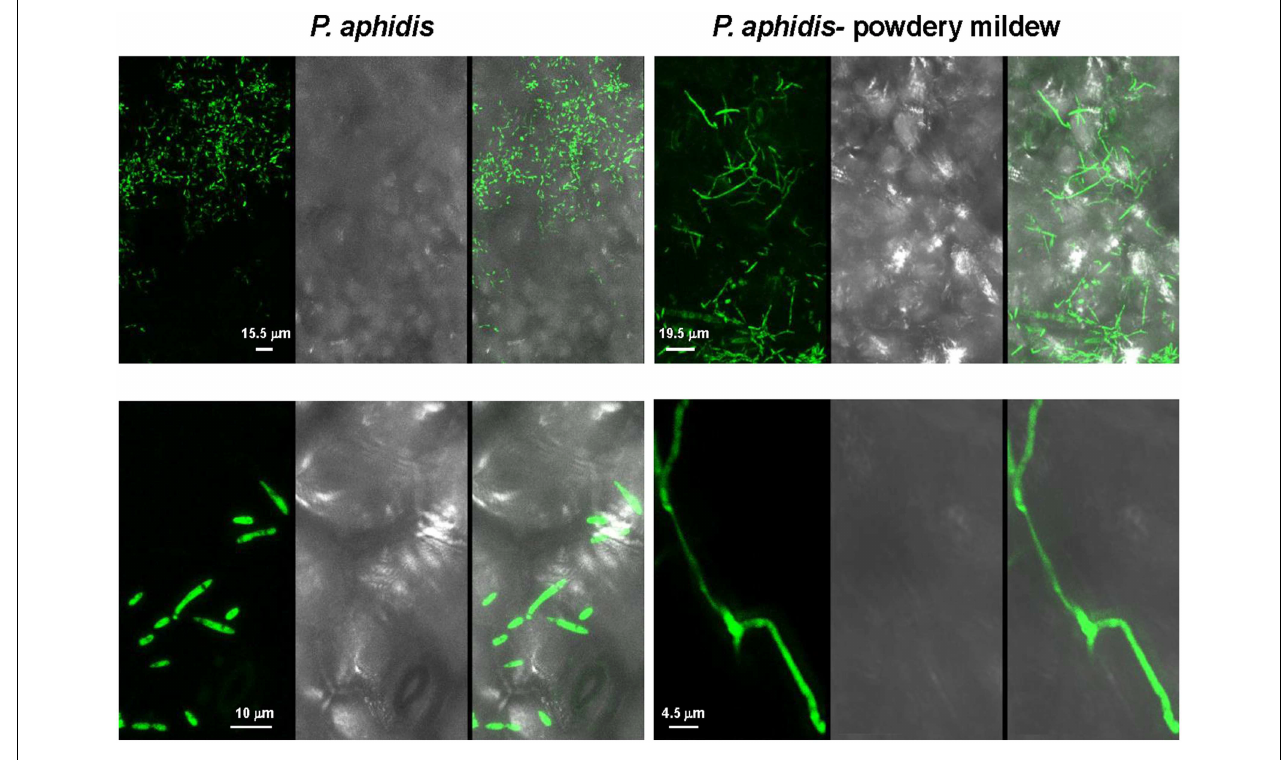
Podosphaera xanthii ( P. aphidis -powdery mildew) or water ( P. aphidis ). The panels, from left to right, depict fluorescence, white light, and overlay images, respectively, for each of the